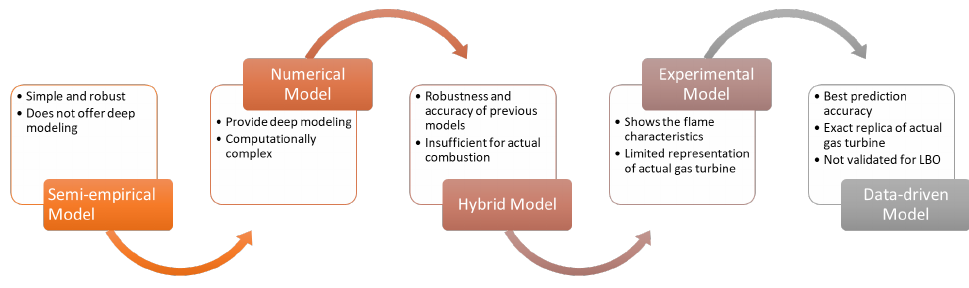
Figure 8. Development of LBO prediction